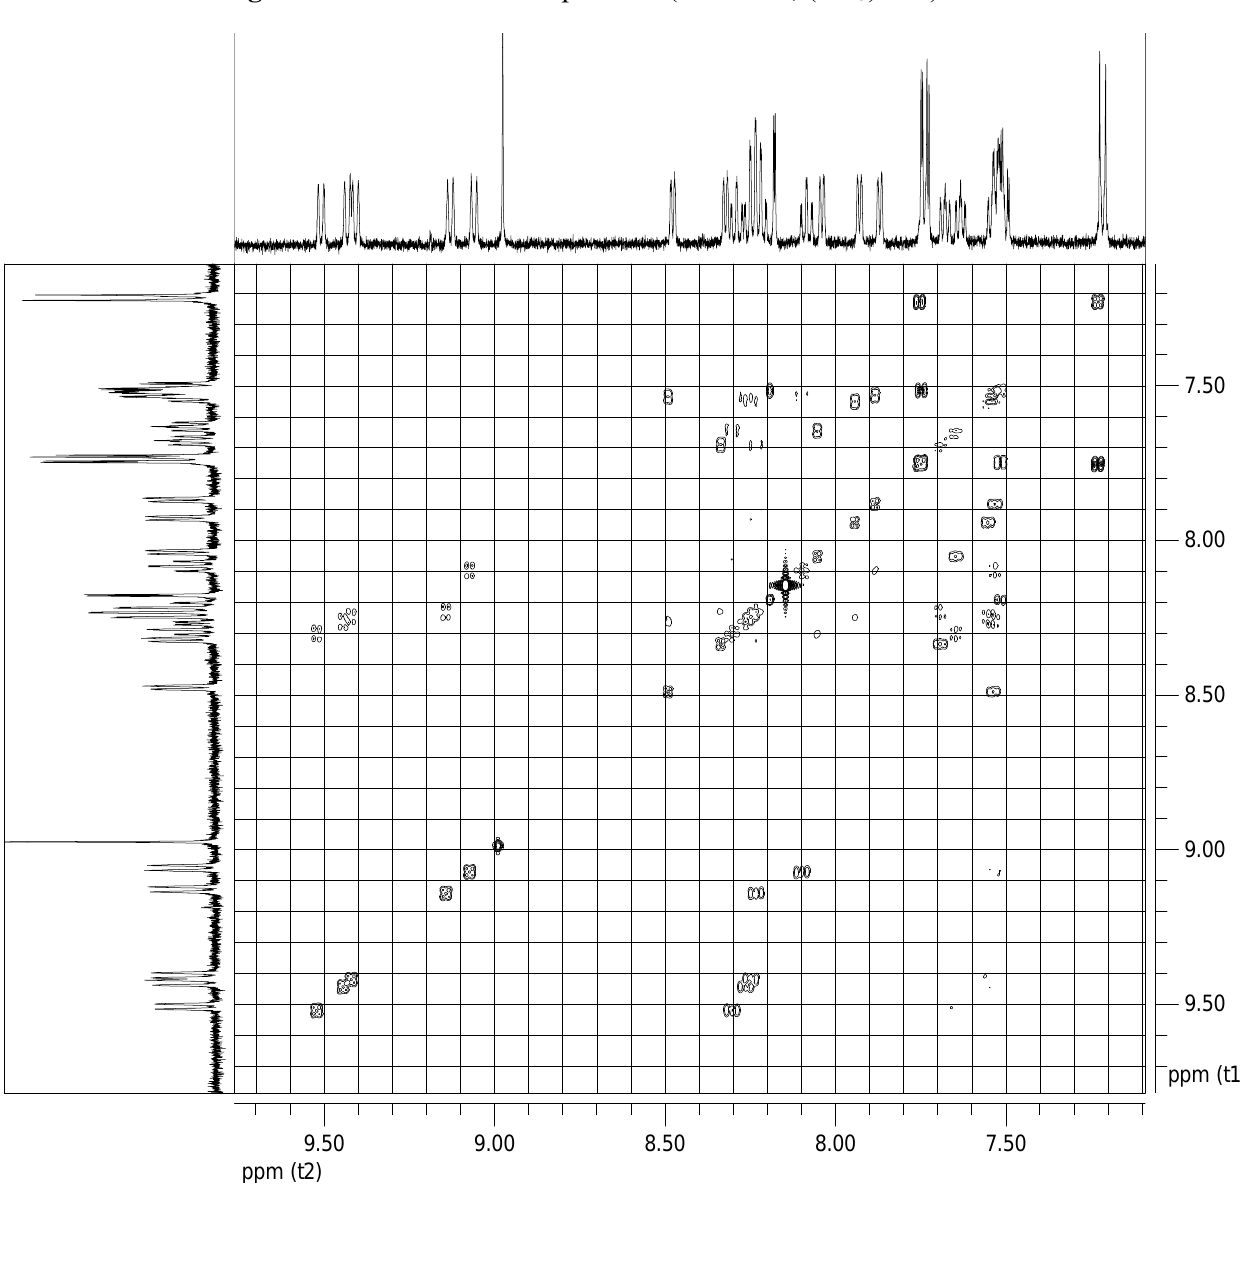
Figure 3. 1 H/ 1 H COSY-45 spectrum (500 MHz, (CD